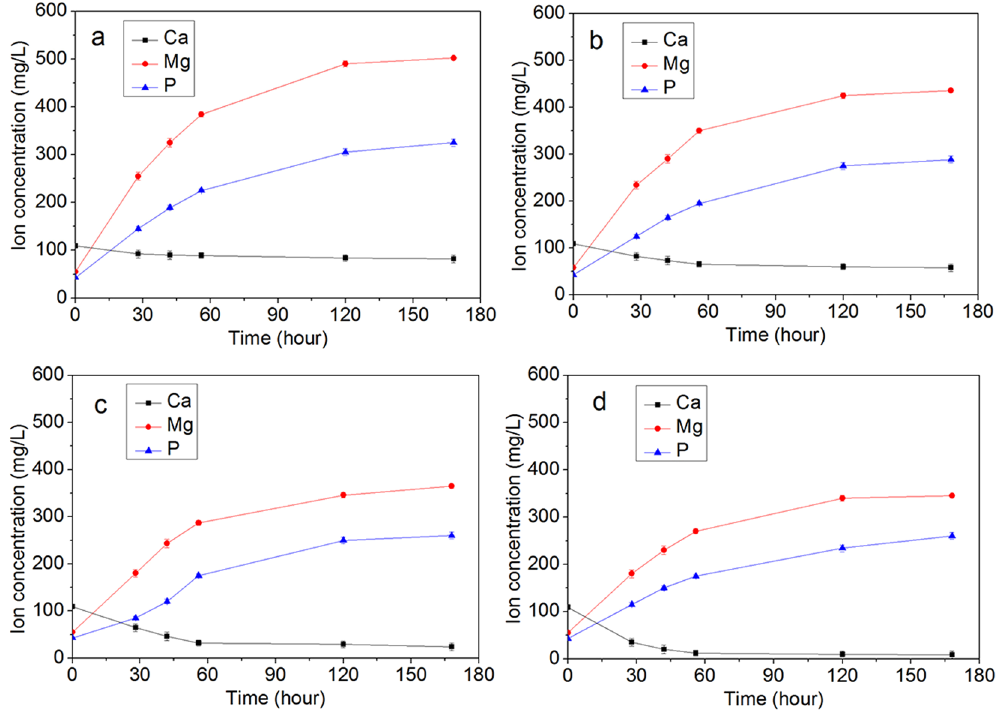
Figure 6. Changes in the Ca, Mg and P ion concentration in the solutions after MP0 ( a ), MP4 ( b ), MP6 ( c ) and MP8 ( d ) were soaked in SBF for different time